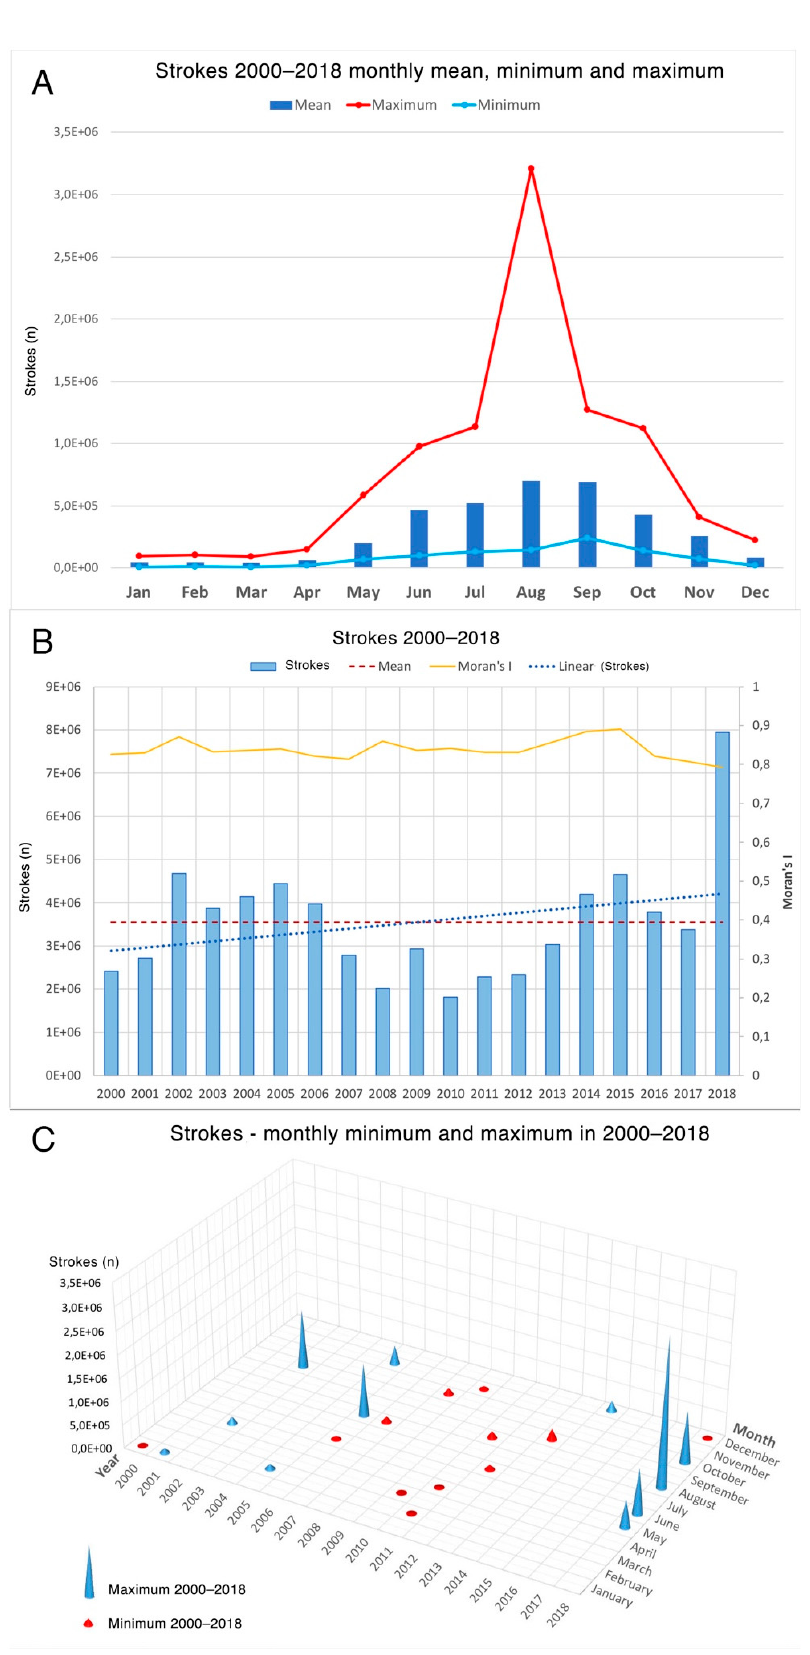
Figure 2. (A ) Minimum, maximum, and mean monthly cloud–ground stroke counts. ( B ) Yearly counts of strokes and global Moran’s I values; mean for total period and linear trend. ( C ) Monthly extreme values for the total period.